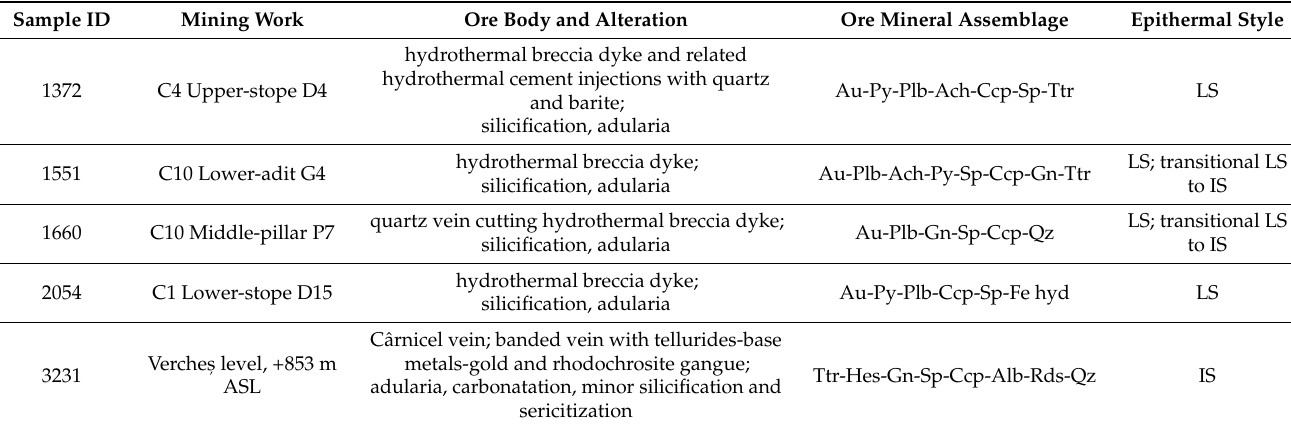
ia Montan ă ore deposits with new EPMA data on ,